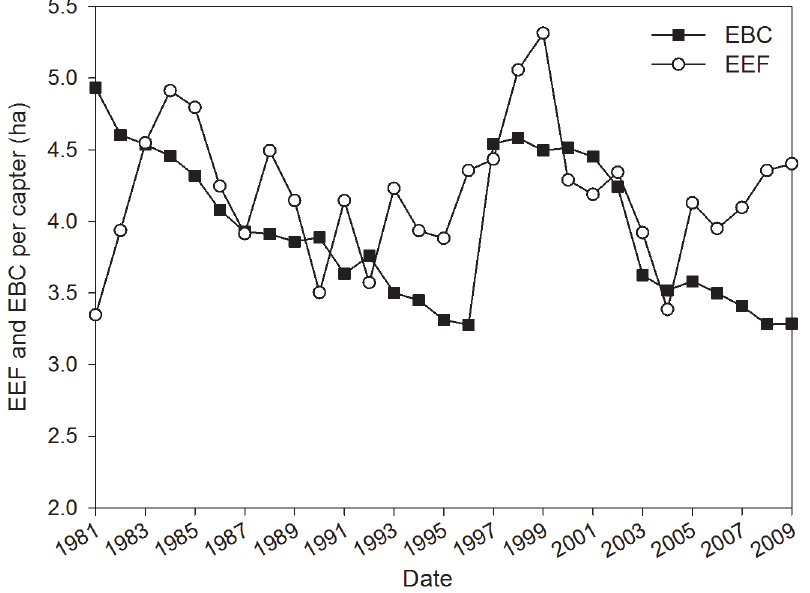
Fig 2. The emergetic ecological footprint (EEF) and emergetic biocapacity (EBC) per capita of cropland in Yuanzhou County, Ningxia Hui Autonomous Region, China during the period 1981 – 2009.